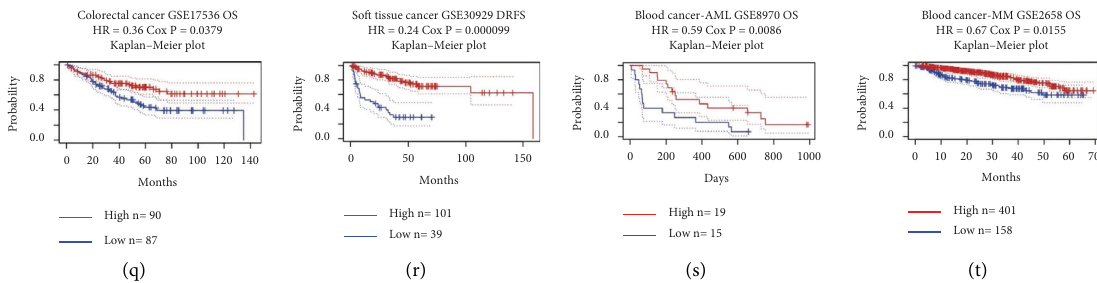
Figure 3: Te prognosis analysis of MYL5 expression in Kaplan–Meier plotter and PrognoScan datasets. Correlation between MYL5 expression and prognosis of various types of cancer in Kaplan–Meier (a–l) and PrognoScan datasets (m–t). OS: overall survival, PFS: progression-free survival, PPS: postprogression survival, FP: frst progression, DRFS: distant recurrence free survival, DMFS: distant metastases-free survival, RFS: relapse-free survival, AML: acute myelocytic leukemia, and MM: multiple myeloma. Table 1: Correlation between diferent clinicopathological factors and the expression of MYL5 gene in BRCA from TCGA database.